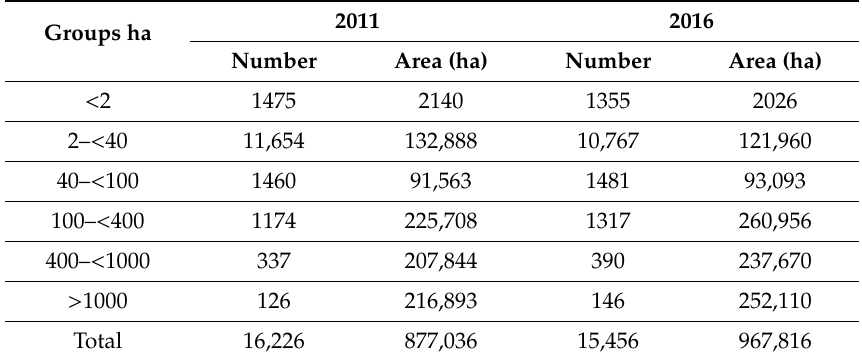
Table 1. Data for land users groups that form according to the area of land users land holdings for the years 2011 and 2016 (ARIB).